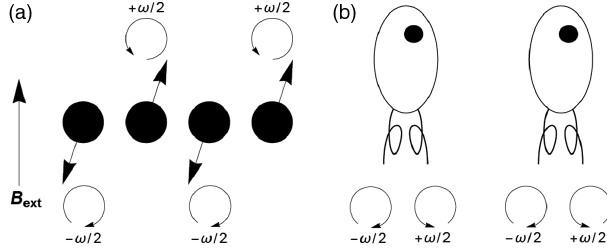
FIG. 2. Schematic representation of (a) the precession frequen- cies of dipoles that are dominantly aligned and antialigned with an applied magnetic field B and (b) the Chlamydomonas cells ext with counterrotating